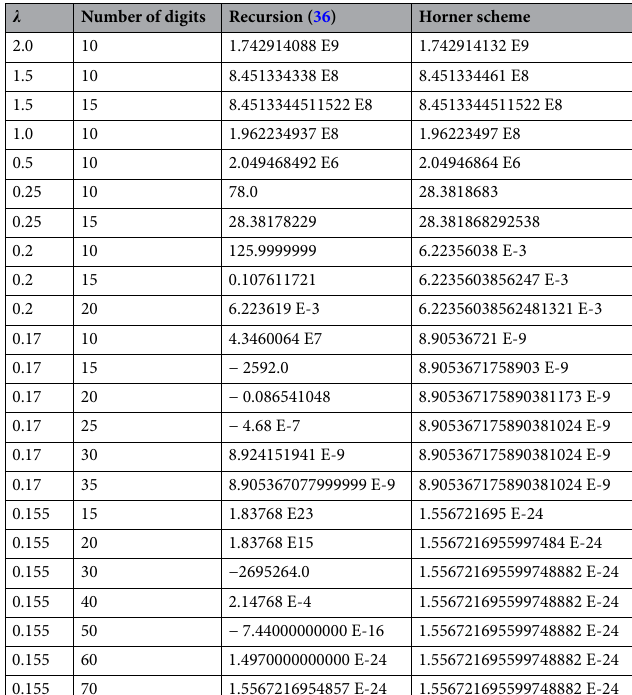
12 14 with different calculation schemes. Computation of p